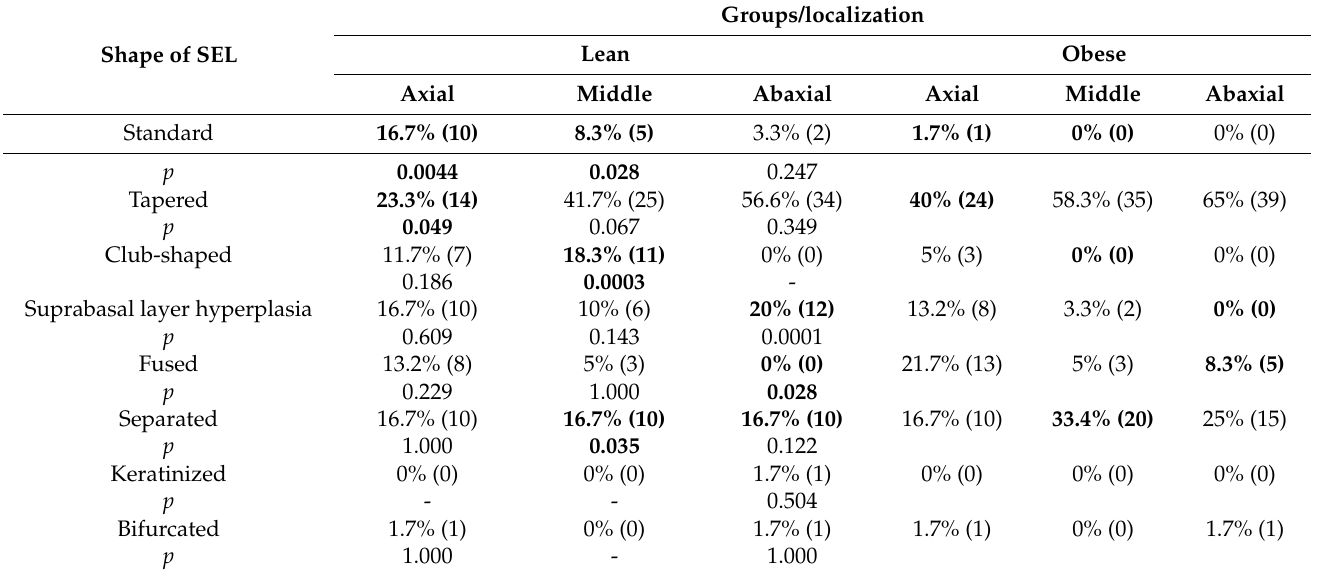
Table 3. Shapes of SELs in examined groups of horses.